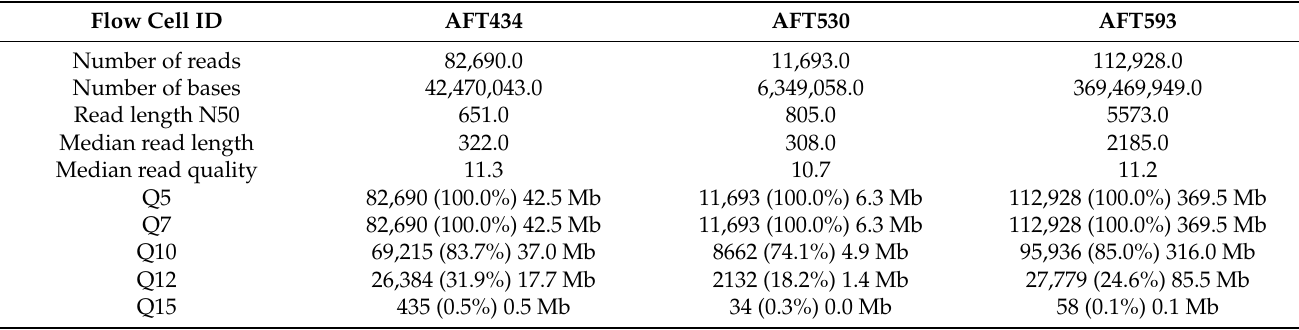
Table 3. Quality of the basecalled reads obtained with